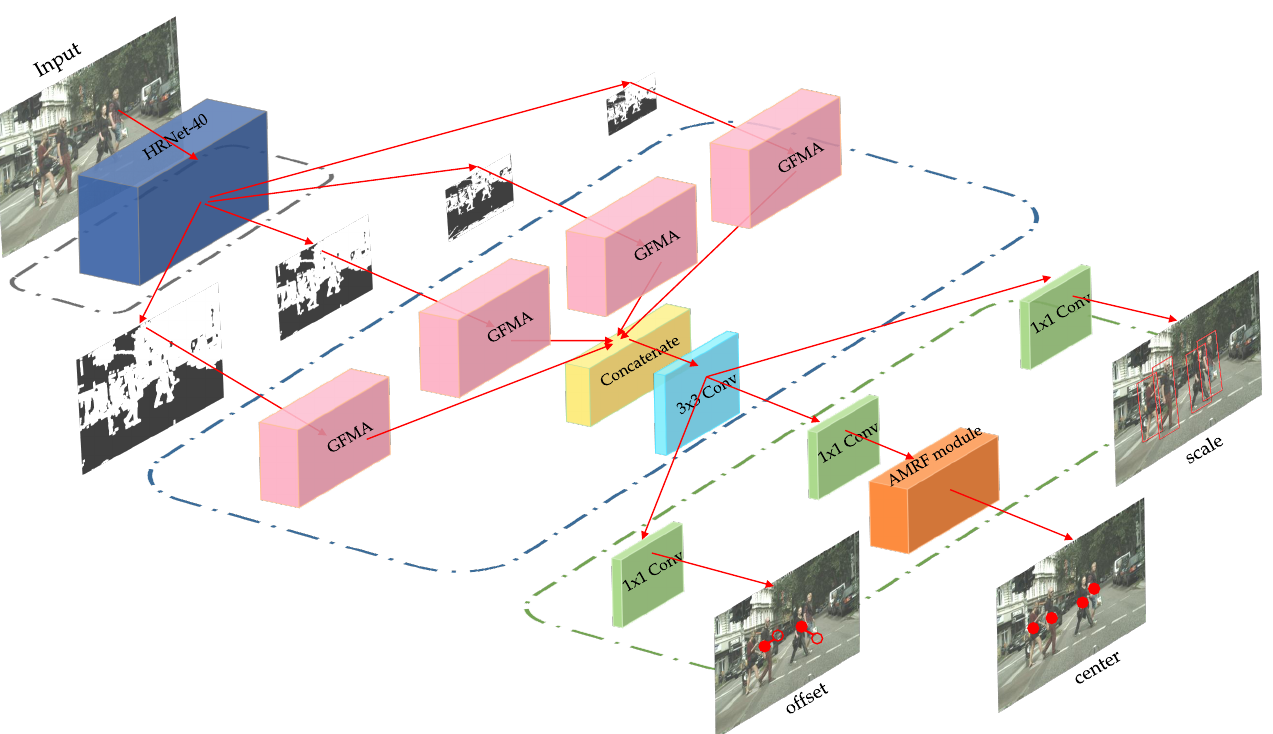
Figure 1. The overview network architecture of CAPNet consists of three parts: a feature extraction module, a global feature mining and aggregation (GFMA) network and a detection head with an attribute-guided multiple receptive field (AMRF)